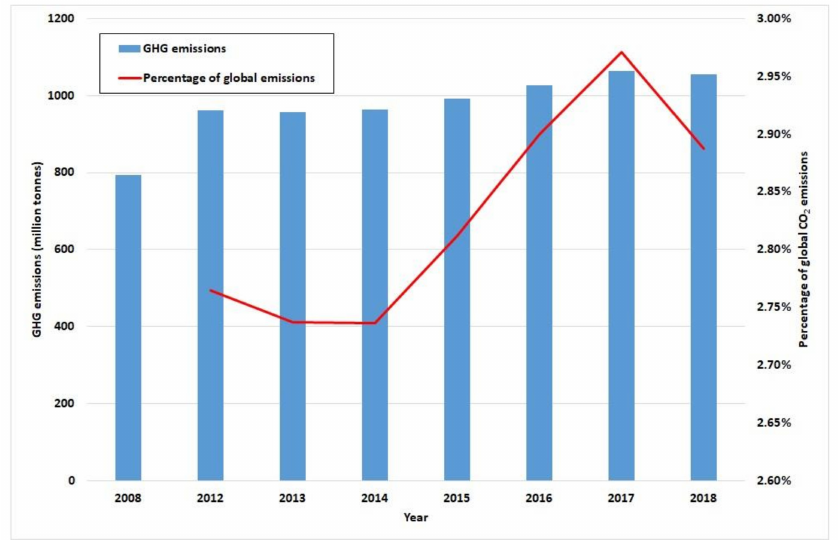
Figure 1. Total estimated greenhouse gas (GHG) emissions from shipping and percentage of total global emissions. Source: drawn up by authors with data from